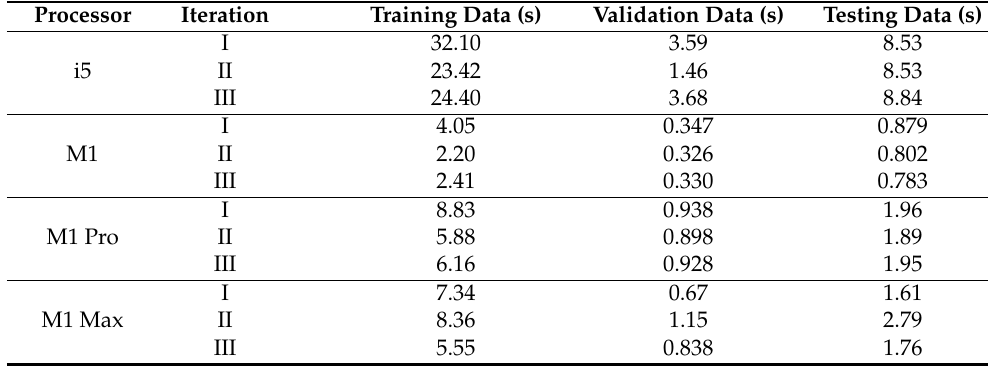
Table 7. Comparison of data analysis times for the ‘ClassifierData’ dataset.